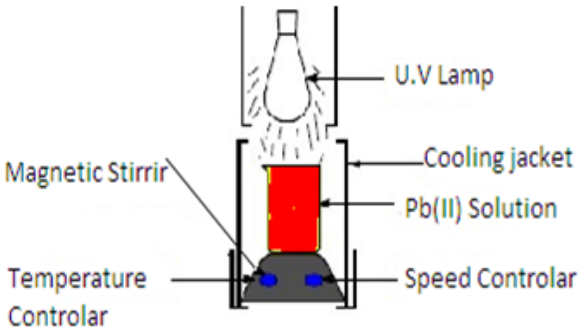
Fig 1. Showing schematic diagram of photocatalytic removal of Pb (II) by magnetic nano adsorbent